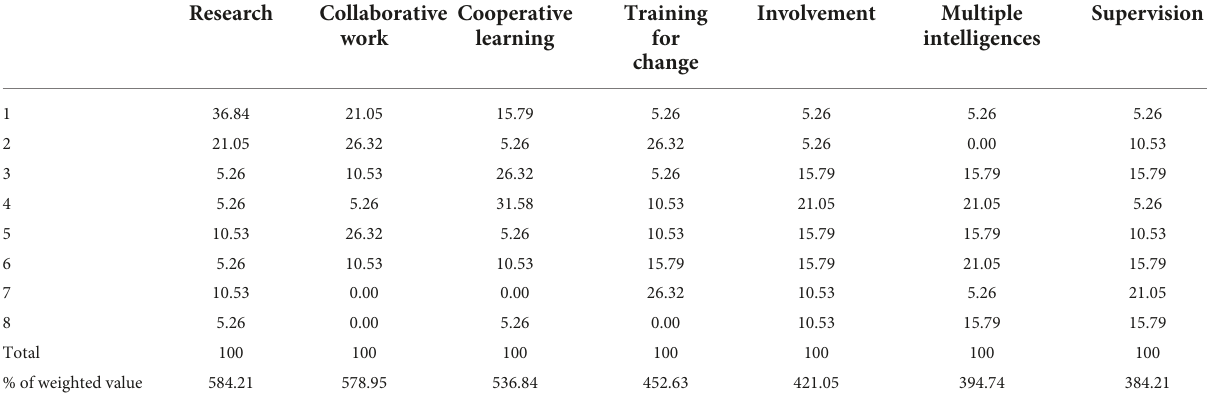
TABLE 14 Opinions on trends in educational innovation, from highest to lowest